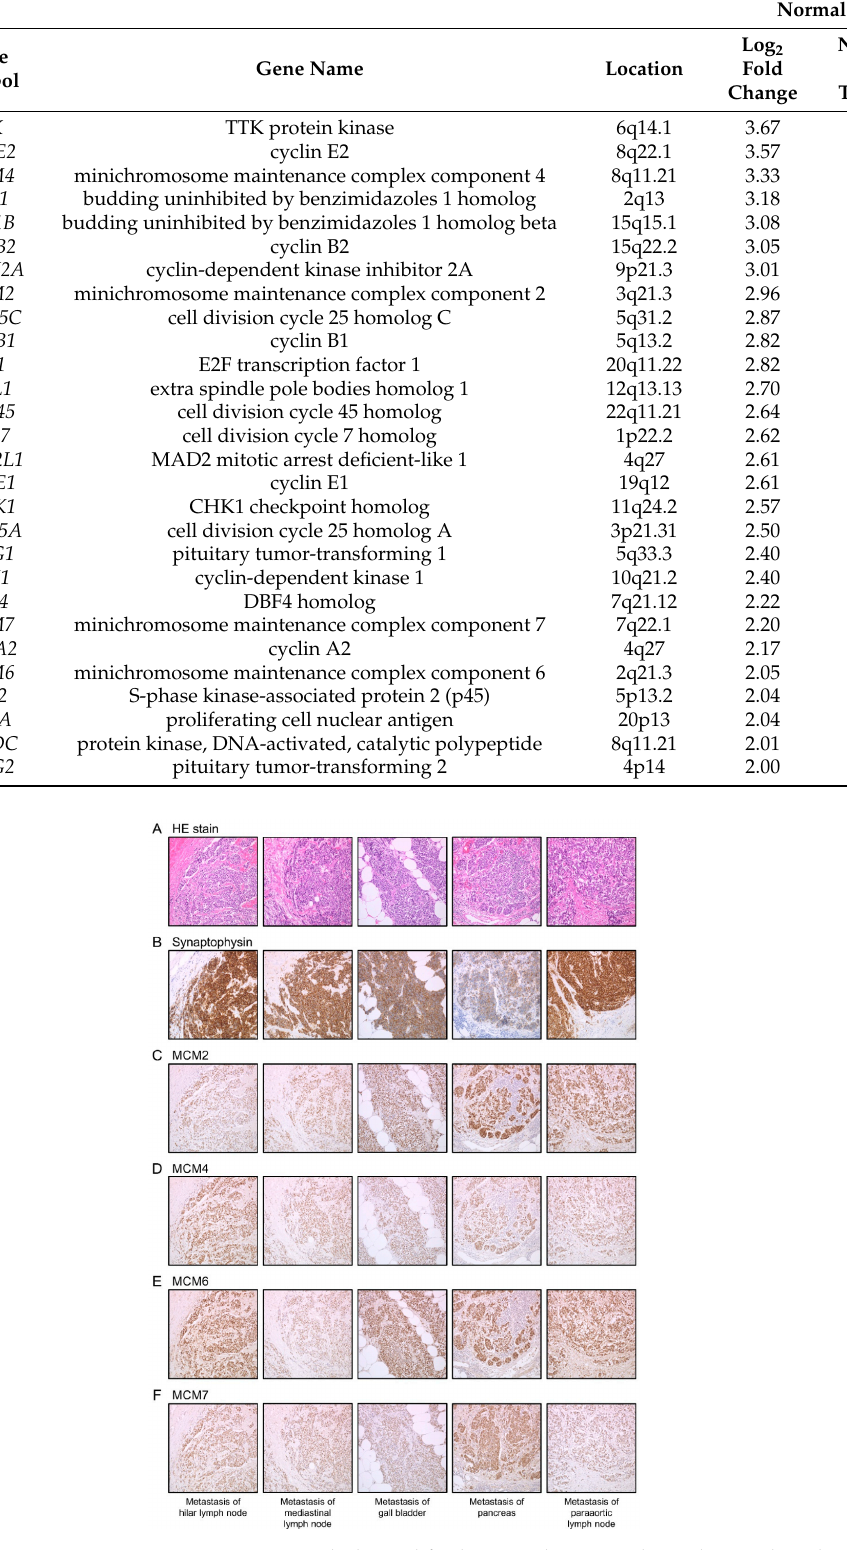
Figure 3. Histopathological findings and immunohistochemical analyses of MCM2, MCM4, MCM6, and MCM7 in case no. 1. Overexpression of ( C ) MCM2, ( D ) MCM4, ( E ) MCM6, and ( F ) MCM7 was observed in the nuclei of cancer cells at the same location as the tumor sites of ( A ) HE stain and the high expression sites of ( B ) Synaptophysin. Micrographs were taken at 200 ×